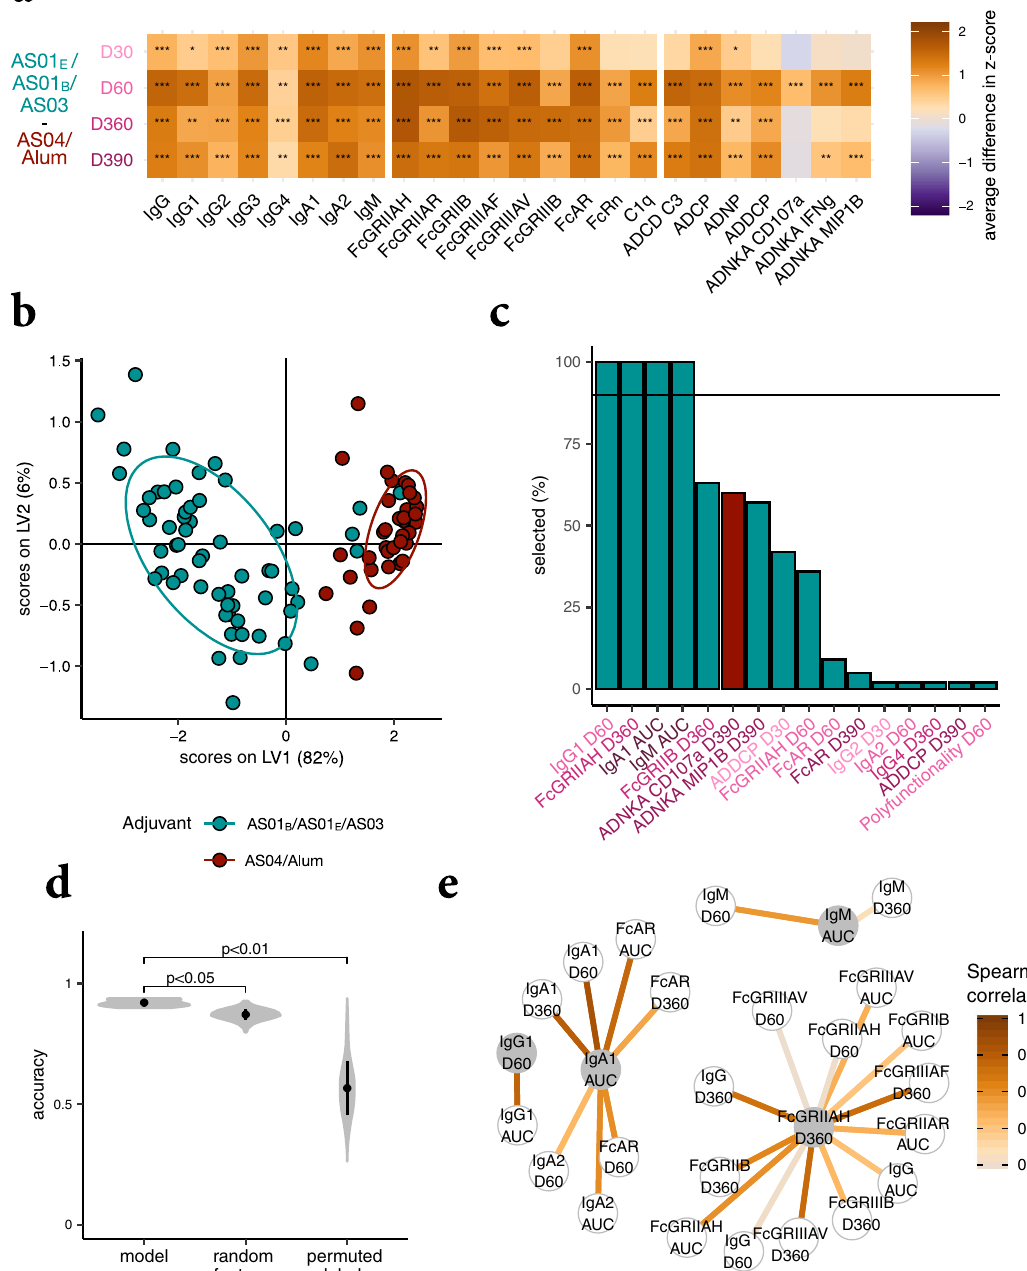
Fig. 3 Dissecting differences between adjuvant clusters. a The heatmap shows differences in the antibody features between the merged AS01 B /AS01 E /AS03 and AS04/Alum-adjuvanted vaccine groups over time. Orange tiles indicate that the feature is on average higher in subjects receiving the HBsAg vaccines containing AS01 B, AS01 E , or AS03, while purple tiles show enrichment in participants receiving HBsAg with AS04 or Alum. Signi fi cances were assessed using Mann – Whitney U tests and corrected for multiple testing using the Benjamini – Hochberg procedure. Asterisks indicate adjusted P values with * P < 0.05, ** P < 0.01, *** P < 0.001. b A PLS-DA model was built based on features selected from all time points and the areas under the curves (AUCs) for the clusters AS01 B /AS01 E /AS03 and AS04/Alum. c The bar graph depicts how often antibody features were selected by repeated LASSO-based selection. The color indicates the adjuvant cluster in which the feature is enriched. The horizontal line shows the threshold of how often a feature needs to be chosen overall in order to be selected for the fi nal set of minimal features. d The modeling approach was validated using permutation tests, for which the performance measured as classi fi cation accuracy of the actual model (using the four selected features shown in panel c ) is compared to control models in a cross-validation framework. For “ random features ” , a fold-speci fi c set of features of the same size as obtained by the LASSO-selection were chosen to train the model, and for “ permuted labels ” the modeling approaches were applied to shuf fl ed group labels. The violin plots show the distribution of classi fi cation accuracies, for 10 repetitions and 100 permutations for the control models, and the P values indicate the median over the 10 repetitions of the exact P values obtained by permutation testing. e A co-correlate network was constructed using Spearman rank correlations. Only correlations with |r| > 0.9 to at least one of the selected features, which are highlighted in gray, are